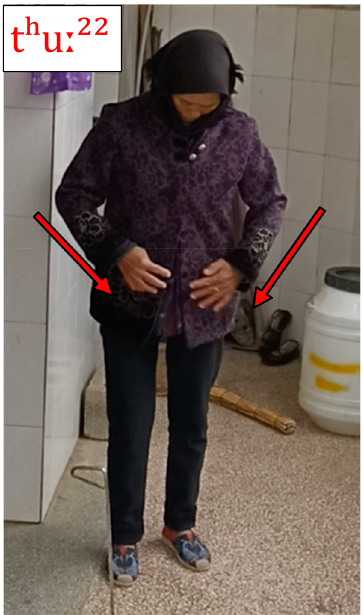
Figure 13: MSN pointing at her own clothing. A photograph was taken during the dialogue in Example 21 which was however not audio